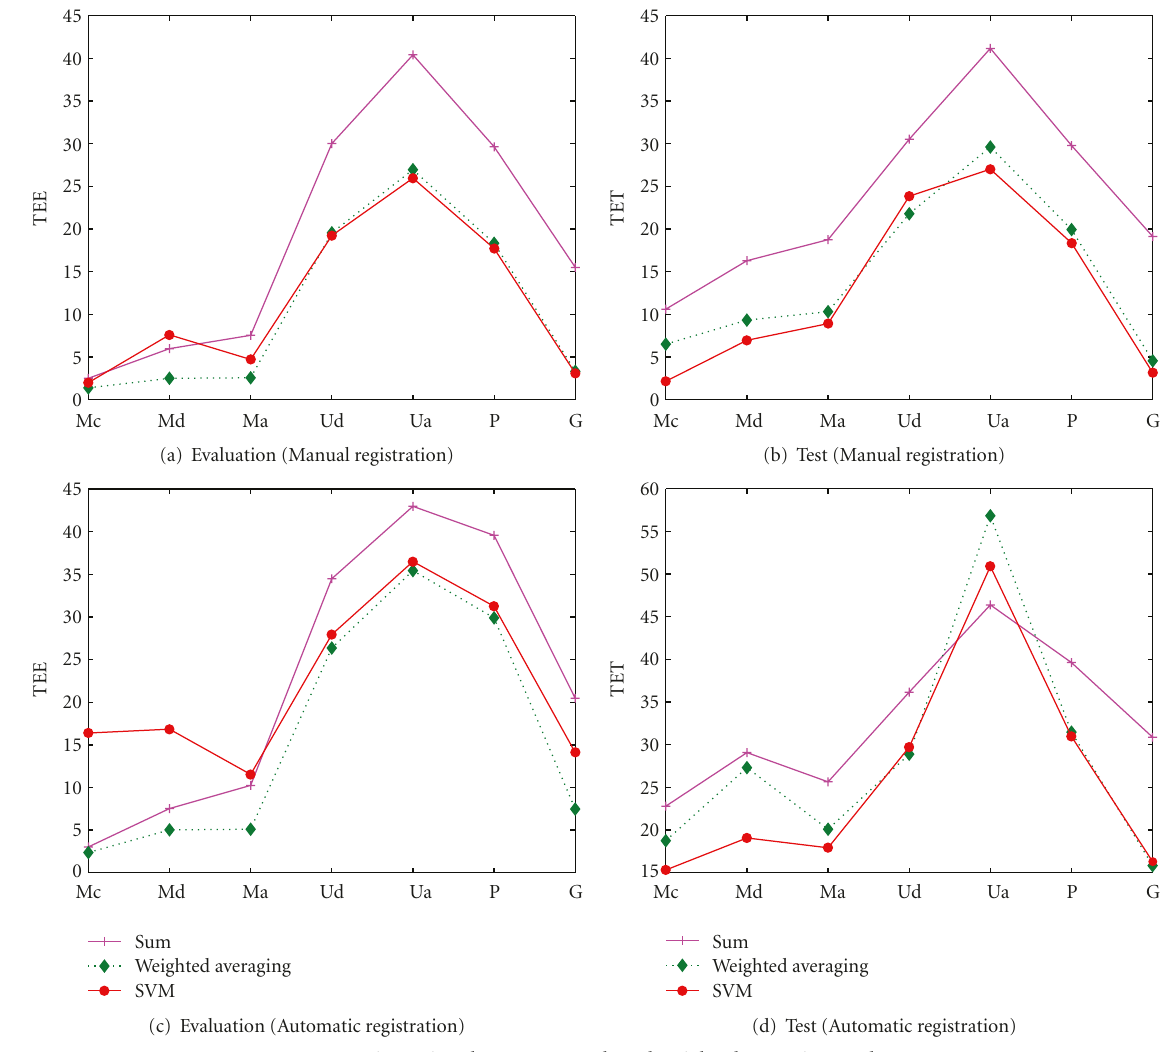
Figure 5: Fusion using the Sum, LDA- based weighted averaging, and SVMs.